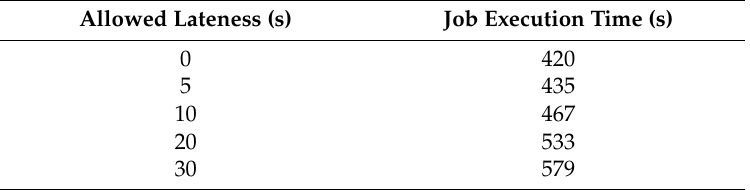
Table 3. Job execution time with the varying value of allowed